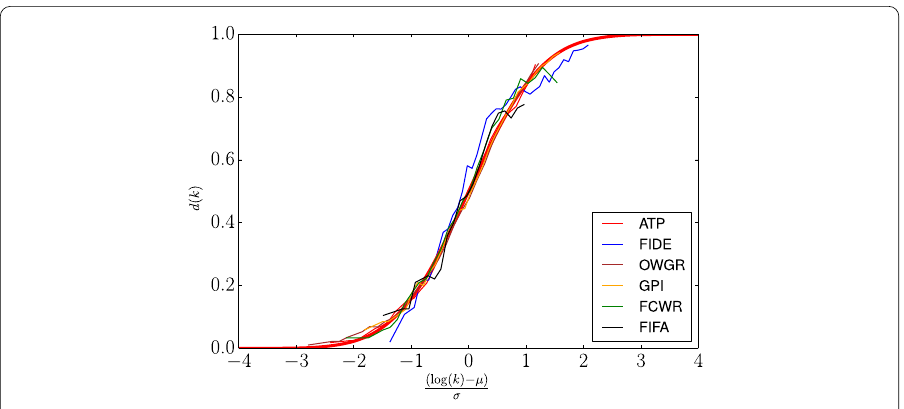
Figure 4 Similarity in the normalized rank diversity across sports and games. Plot showing a comparison of the rank diversity d ( k ) for all activities considered. With the values of μ and σ we